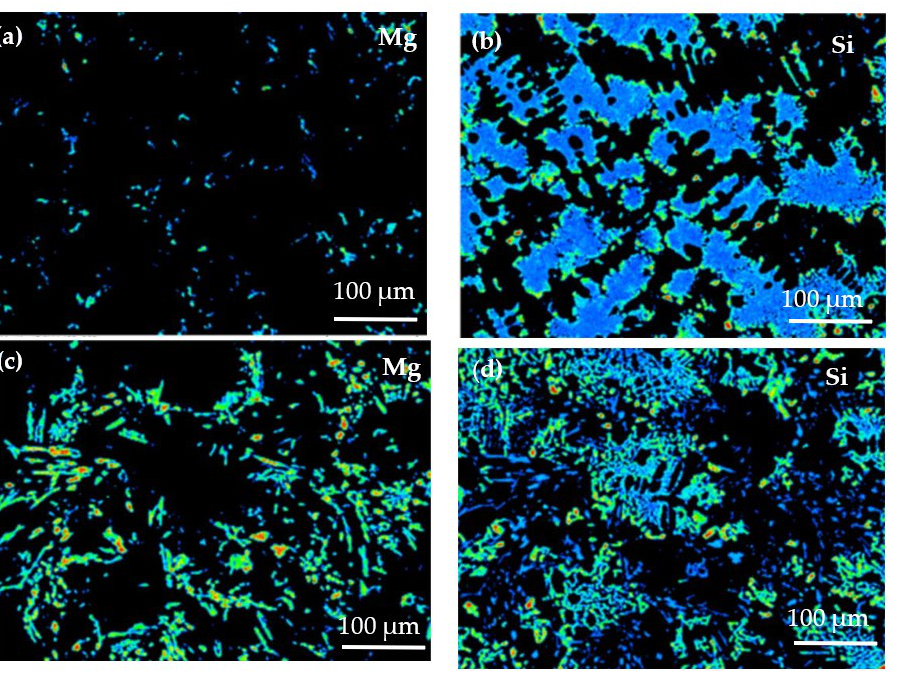
Figure 8. Distribution analysis of Mg and Si through EPMA: ( a ) and ( b ) Al−17Si−4Cu−0.5Mg , ( c ) and ( d ) Al−17Si−4Cu−2.5Mg .